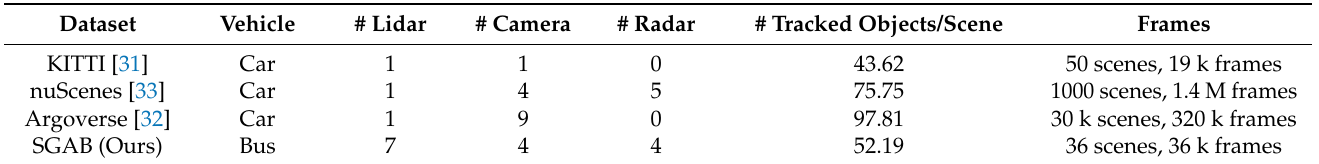
Table 1. Autonomous driving datasets for detection, tracking, and prediction. We compare readily available datasets with our own. We show that SGAB is the only dataset collected from an autonomous bus with a large number of different sensors as